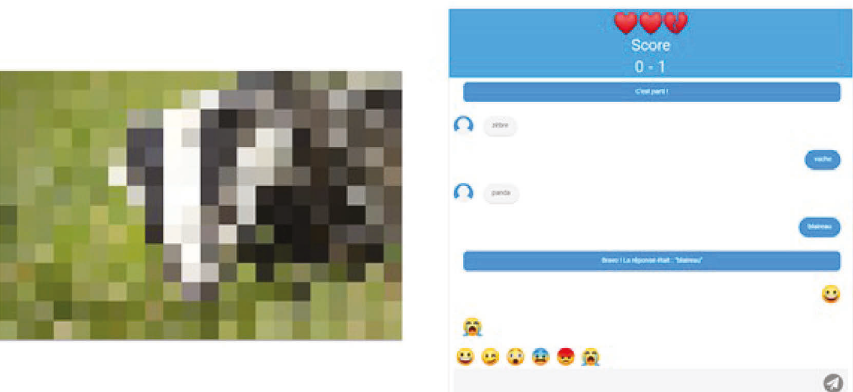
Figure 2: Interface of the web application developed for the experiment including the emoticons for the PH-EC and C-EC